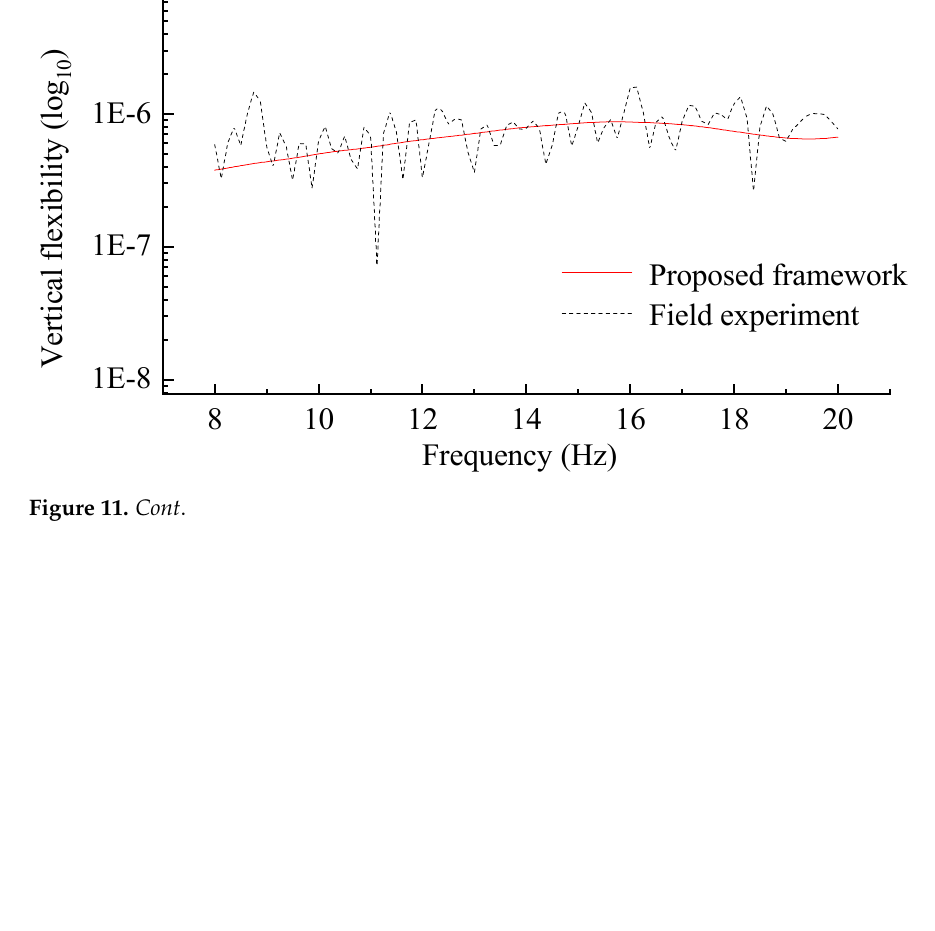
Figure 10. Sensors used in the test.